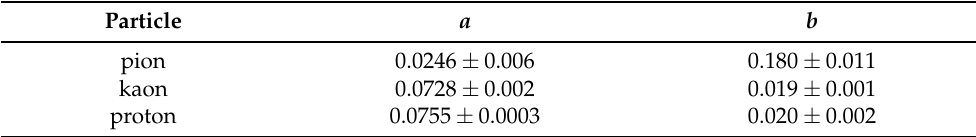
Figure 3. (Color online) Transverse momentum spectra of identified charged hadrons (pions, kaons, √ s NN = 0.9, 2.76 and 7 TeV. Experimental data protons) in pp collisions in the range | y | < 1, at measured by the CMS Collaboration [20] are shown by the scattered symbols. The model results are shown by the solid line. Table 1. Values of a and b for pion, kaon and